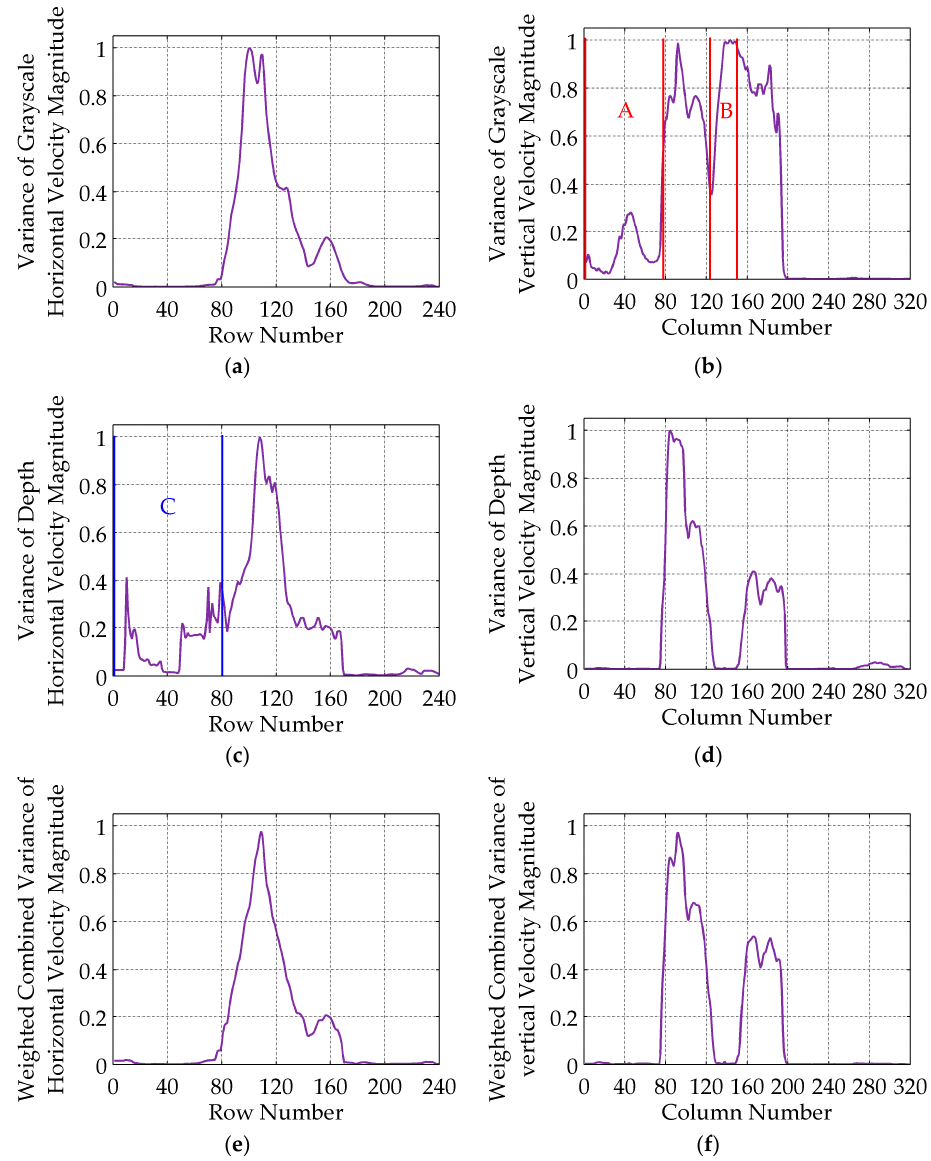
Figure 3. Row and column variance vectors of grayscale and depth velocity magnitude. ( a ) Row variance vector rt G S , of grayscale horizontal velocity magnitude; ( b ) Column variance vector ct G S , of grayscale vertical velocity magnitude; ( c ) Row variance vector rt D S , of depth horizontal velocity magnitude; ( d ) Column variance vector ct D S , of depth vertical velocity magnitude; ( e ) Weighted combined row variance vector rt DG S , , of horizontal velocity magnitude; ( f ) Weighted combined column variance vector ct DG S , , of vertical velocity magnitude. rt G S , , ct G S , , rt D S , and ct D S , are normalized. Usually, the motion of MBPs would cause changes in both grayscale and depth. But the depth of regions with moving shadow or illumination change remain nearly unchanged; the grayscale of regions with larger motion caused by depth value loss are mostly stable. Although clothes